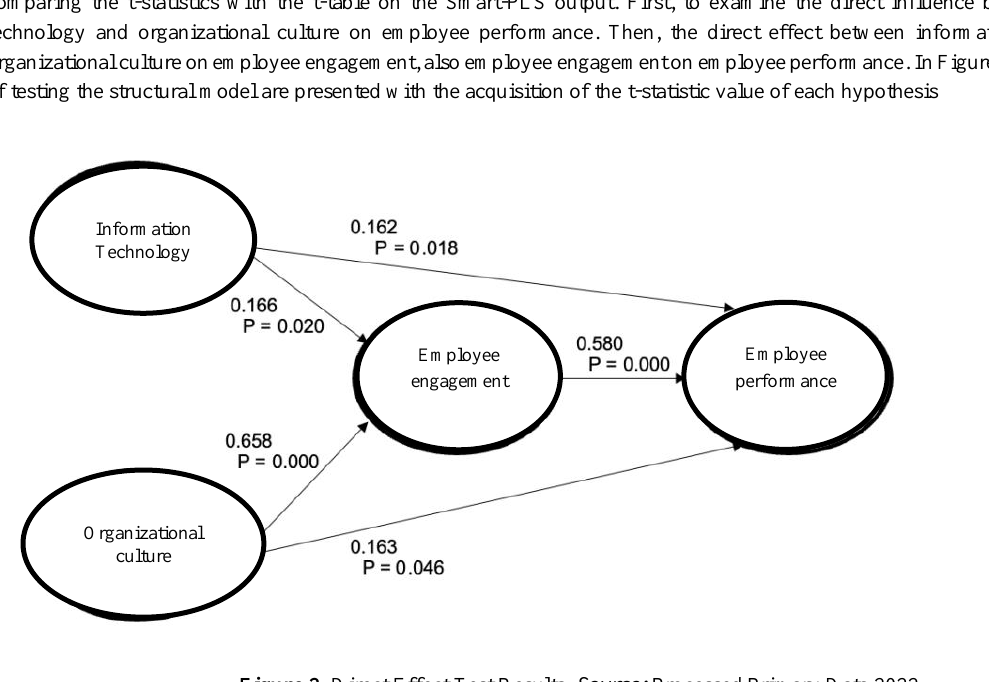
Figure 2. Direct Effect Test Results; Source: Processed Primary Data 2022